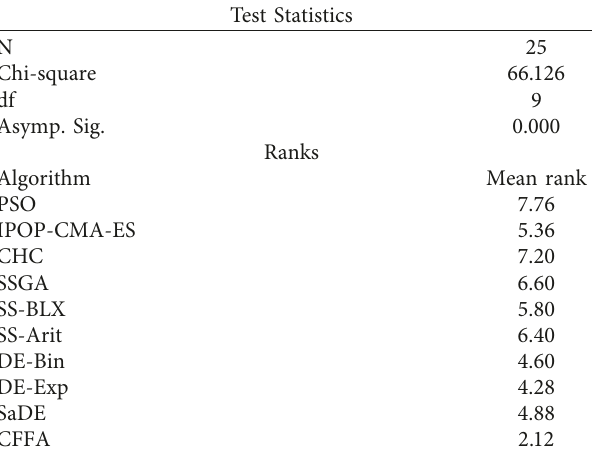
Table 4: Friedman test results for the 25 CEC ′ 2005 benchmark